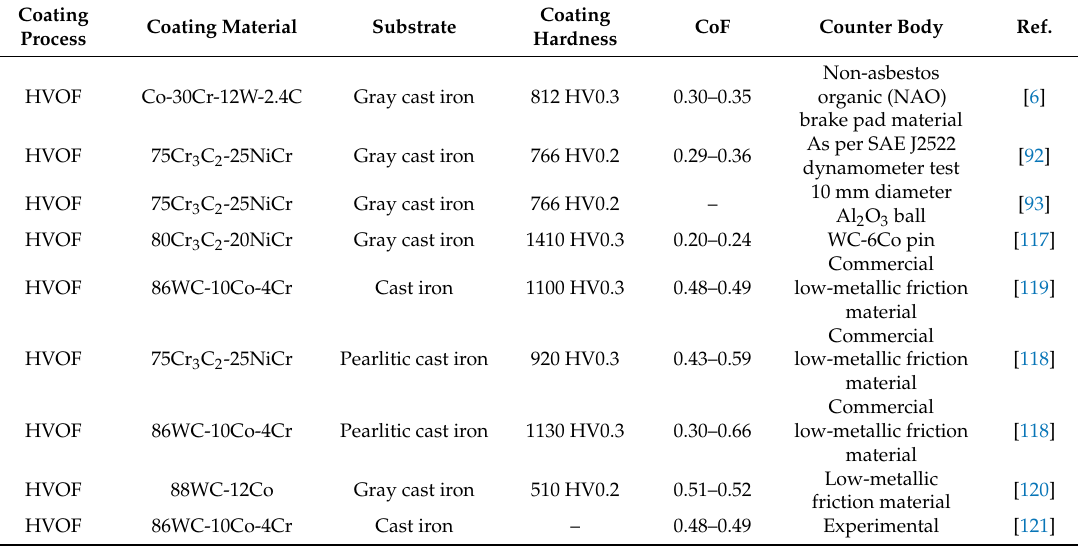
Table 4. Summary of sliding wear studies involving carbide coatings on brake discs.